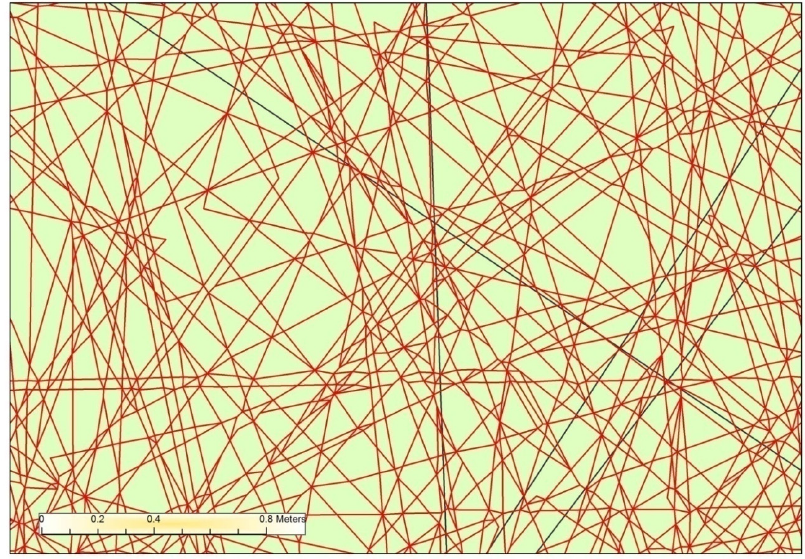
Figure 19. Map showing GPS tracks of island field visit, 22–23 August 2013 (1:10) (Base map data: © Crown Copyright and Database Right [2013], Ordnance Survey (Digimap